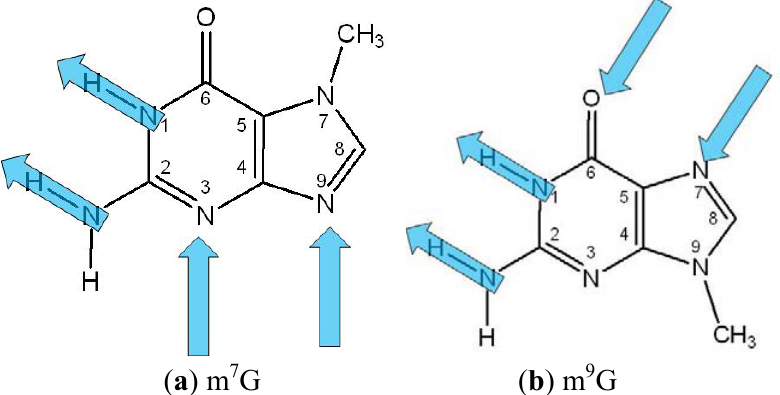
Figure 1. ( a ) The 7-methyl (m 7 G) and ( b ) the 9-methyl (m 9 G) substituted forms of guanine with optimal H-bonding directions in ring